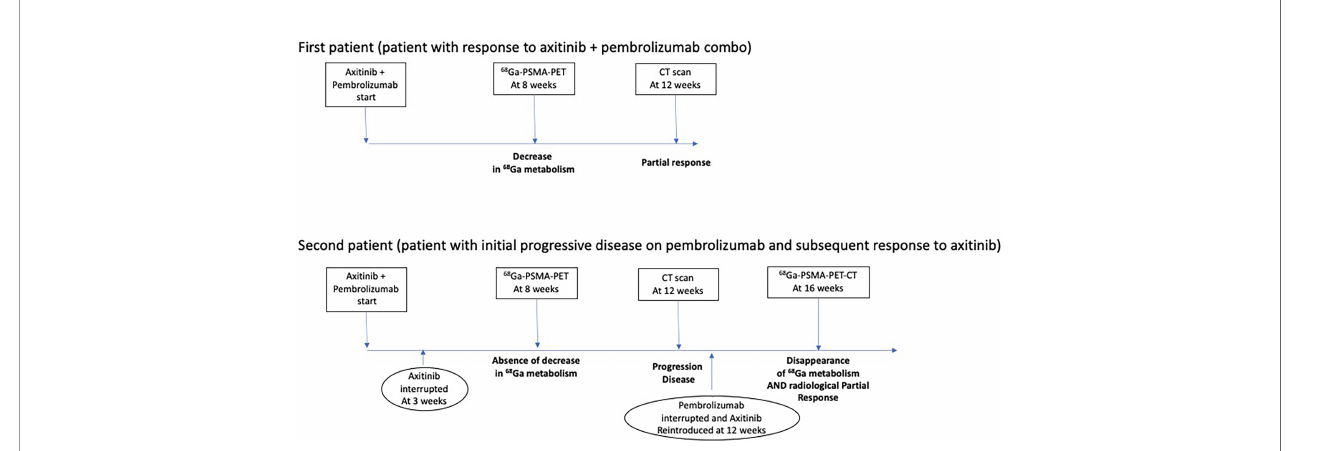
FIGURE 3 | Timeline with imaging and response to therapies in the two clinical cases.